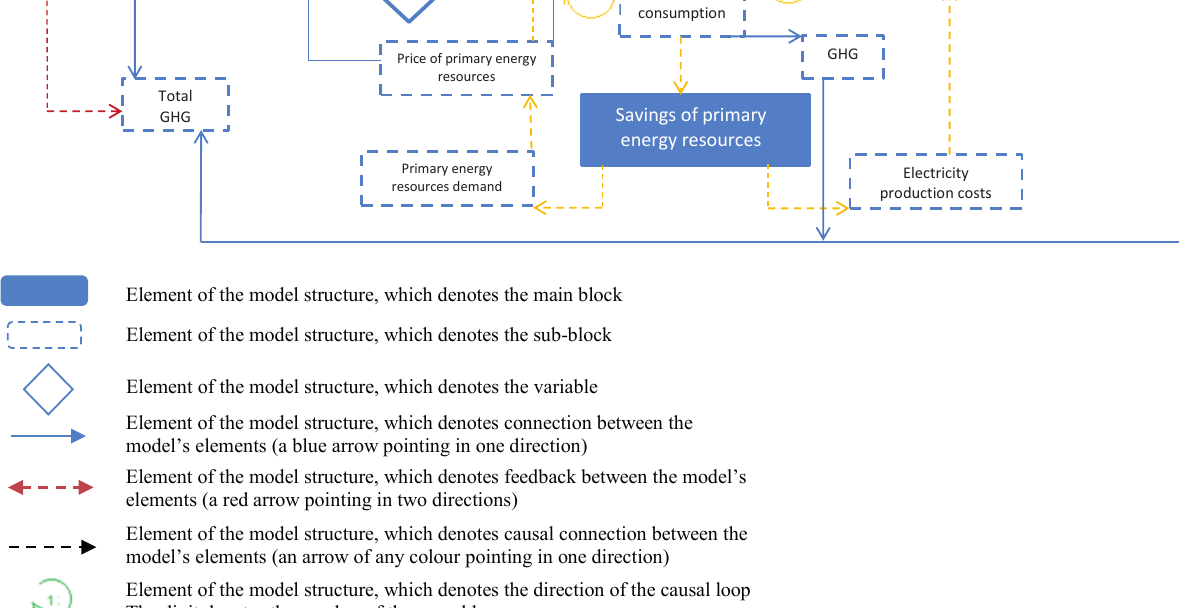
Fig. 2. Structure of the system dynamics model for evaluation of the impact of integration of RES on the operational efficiency of energy supply